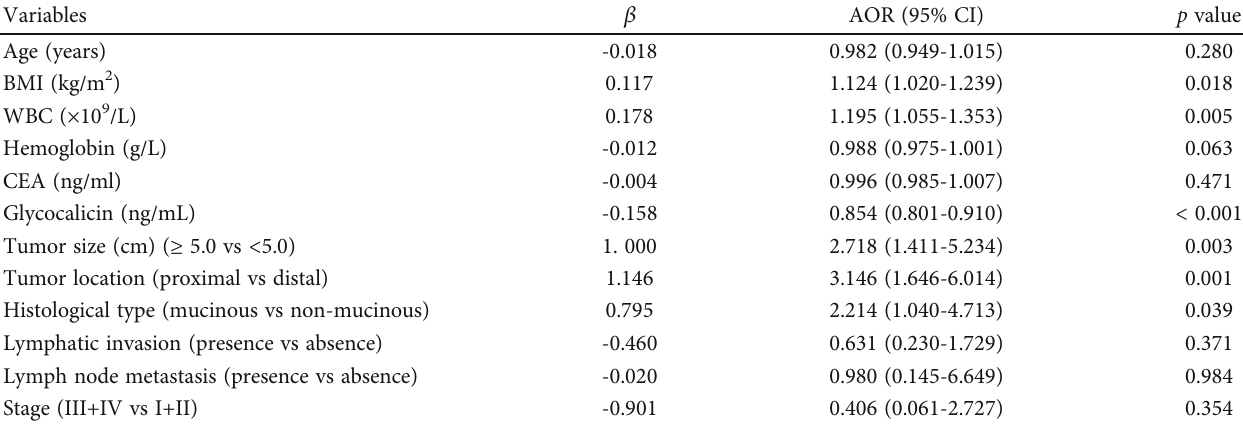
Table 3: Logistic regression analysis for the associations between glycocalicin and microsatellite instability status among colorectal cancer patients.